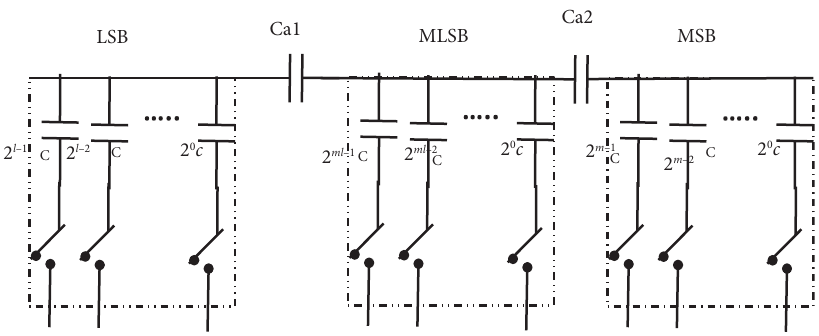
Figure 11: Te dual split three-stage subarray